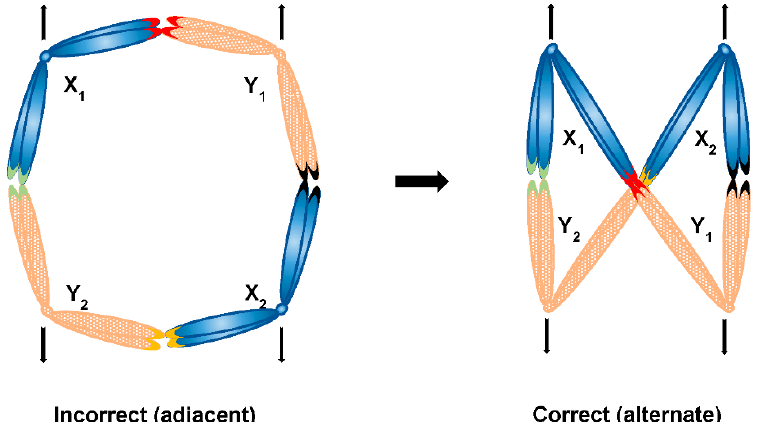
Figure 8. Possible segregation modes of a ring sex chromosome multiple consisting of four sex chro- mosomes (X 1 X 2 Y 1 Y 2 system)—in case of a plain ring, segregation of sex chromosomes would be adjacent, which would in turn lead to the incorrect segregation of X and Y chromosomes together; in case of a figure eight shaped ring, alternate segregation is achieved leading to the correct segregation of Xs together and Ys together respectively; respective contacts of sex chromosomes (e.g., PARs) are depicted as coloured chromosome tips.